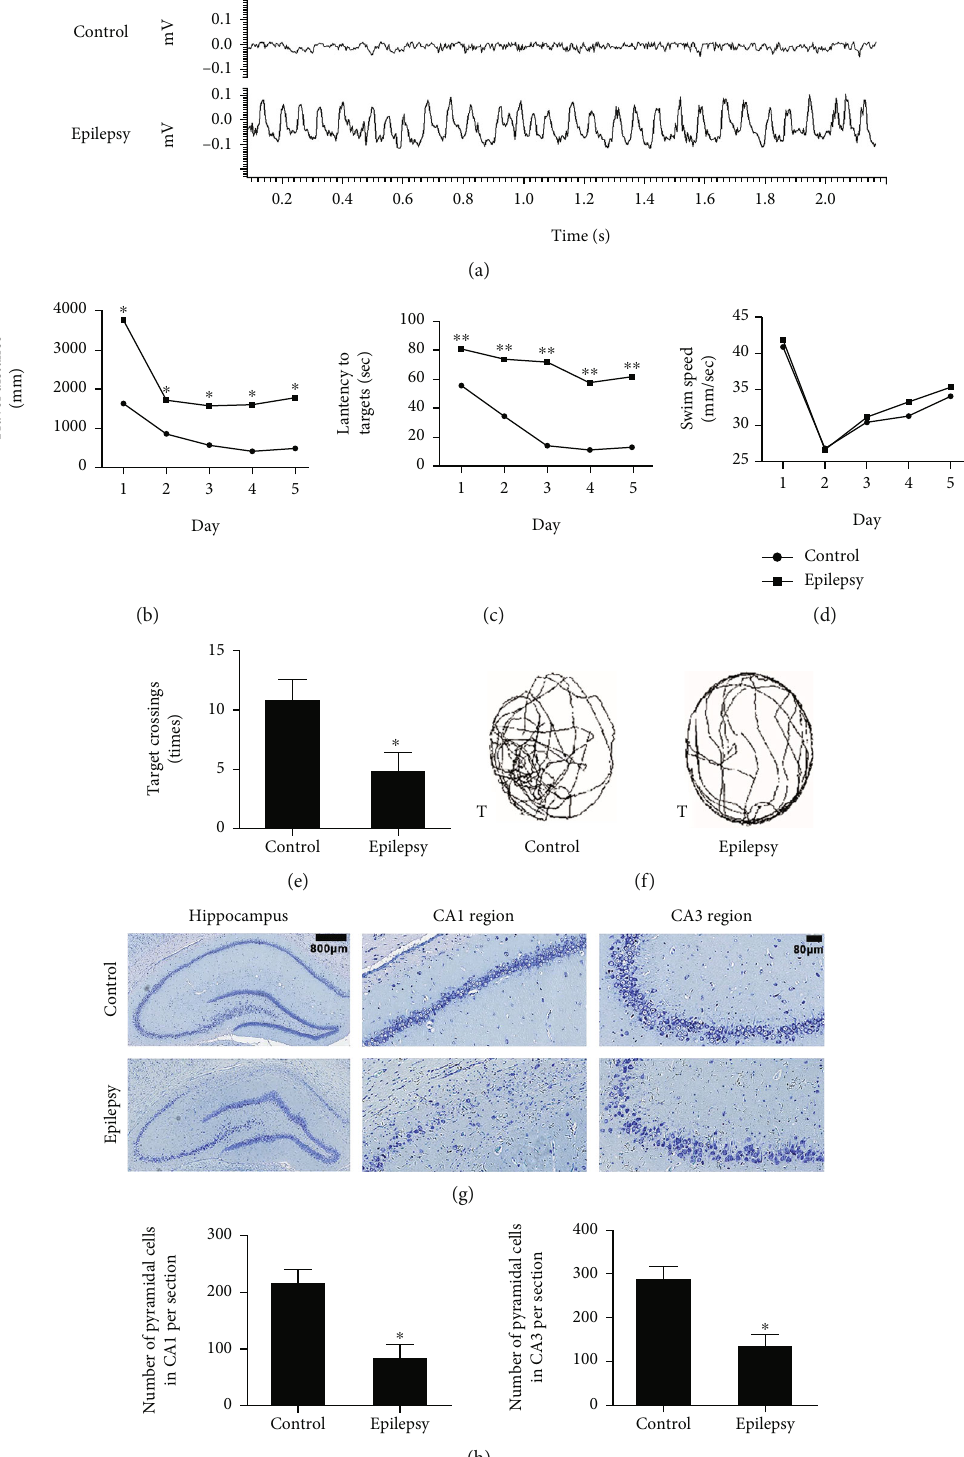
Figure 1: The behavioral changes and hippocampal injury in TLE rats. (a) Manifestation of EEG in rats. (b – f) Morris water maze test. (b) Swim path length; (c) latency to mount the underwater platform; (d) mean swim speed. E: the number of crossings of the target quadrant; F: the tracks of searching for the target quadrant in the probe trial (T: target quadrant). ∗ P < 0 : 05 compared to control group; ∗∗ P < 0 : 01 compared to control group ( means ± SD , n = 8 ). (g, h) Nissl staining of hippocampus. (g) Formation of hippocampus, CA1 and CA3 regions; (h) quantitative analysis of pyramidal neurons in CA1 and CA3 regions. ∗ P < 0 : 05 compared to control group ( means ± SD , n = 5 ). n refers to the numbers of